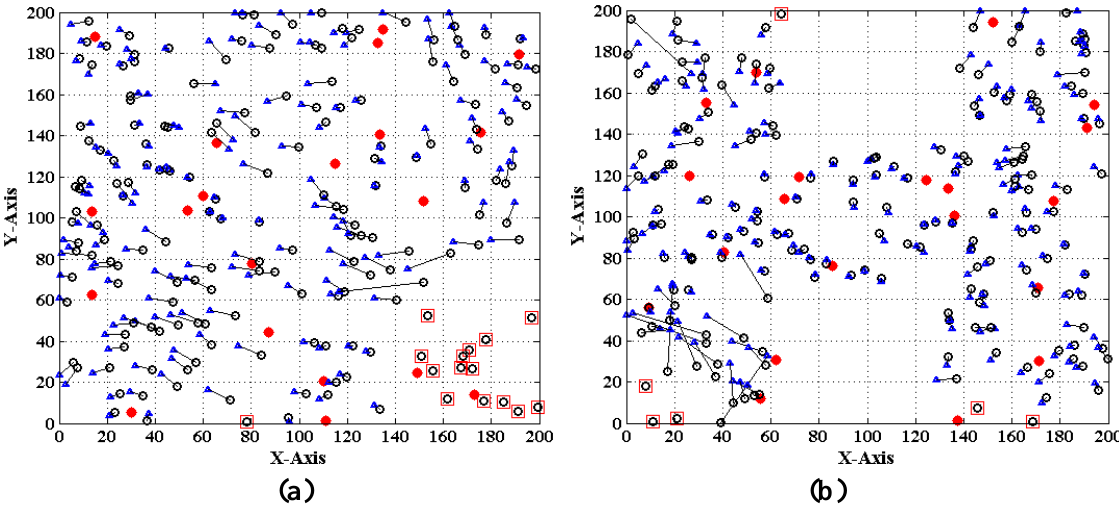
Figure 24. Localization results of iterative algorithm. (a) Isotropic network. (b) Anisotropic network.